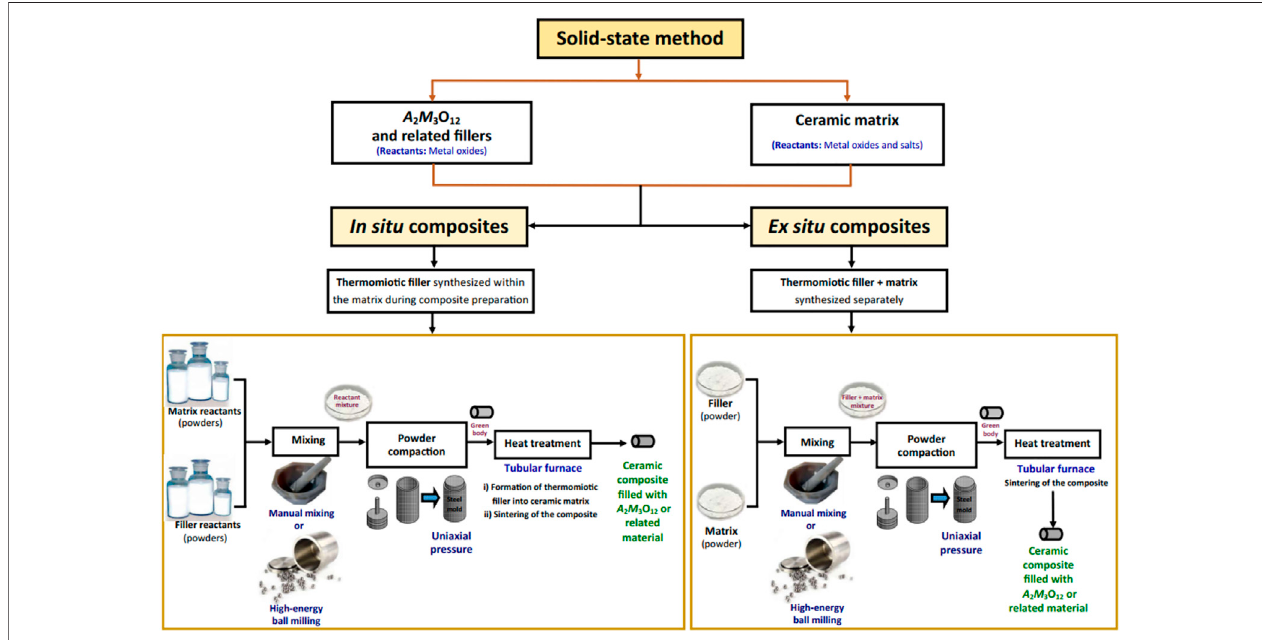
FIGURE 14 | Scheme showing solid-state preparation and processing of ceramic matrix composites (CMCs) fi lled with A 2 M 3 O 12 or related materials.